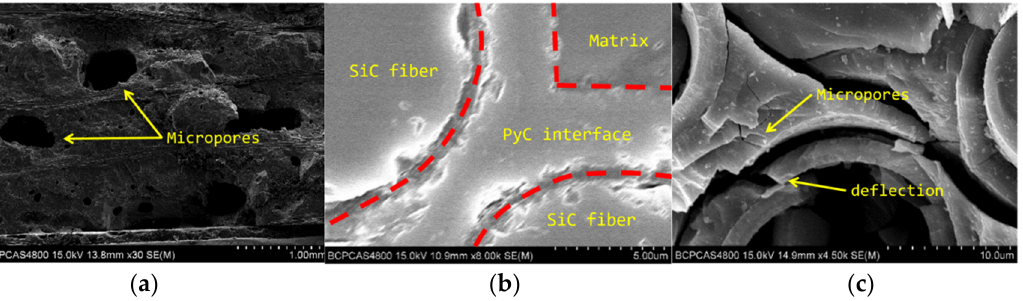
Figure 11. The SEM of SiCf/PyC/SiC composites ( a ) SiC matrix ( b ) PyC interface ( c ) Fracture of com- posite.